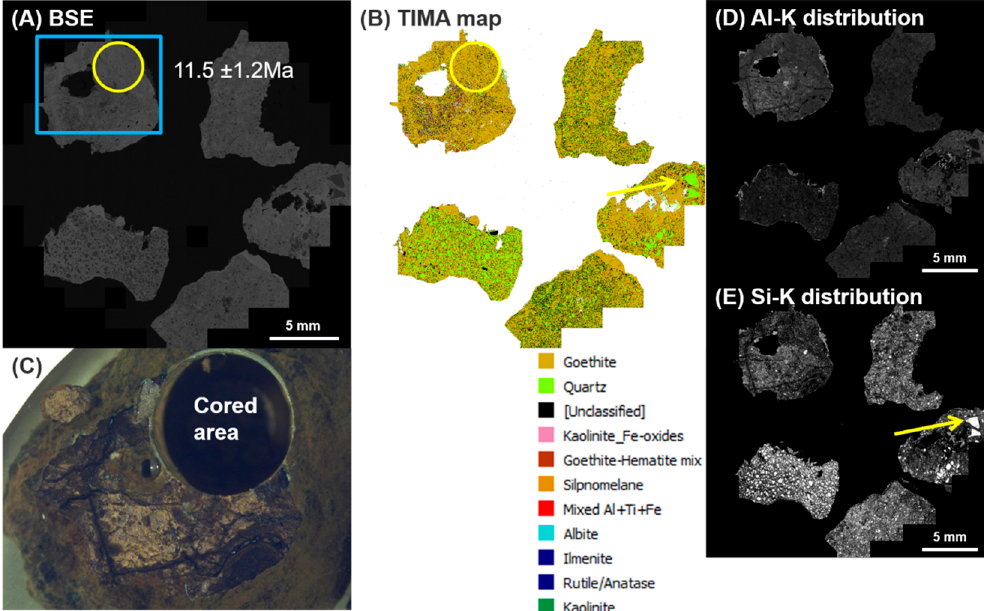
Figure 20. Composite back-scattered electron (BSE) ( A ) and TIMA ( B ) mineral distribution map of the NWS (#25450) used to locate areas suitable for (U–Th)/He-dating (area circled in yellow). The blue box in ( A ) frames the nodule shown in more detail in the optical image ( C ) after coring to collect material for dating. Element maps of the Al ( D ) and Si ( E ) distribution also aid in identifying areas suitable for (U–Th)/He-dating. Bright, white-contrast specks in the Si–K map (high Si content— E , yellow arrow) indicate the presence of quartz.